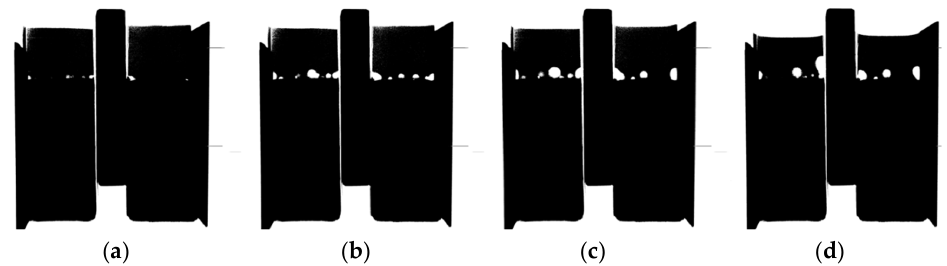
Figure 19. Void development when water is absorbed by the mortar substrate: ( a ) Reference image; ( b ) After 7 min; ( c ) After 17 min; ( d ) After 240 min. ( b ) After 7 min; ( c ) After 17 min; ( d ) After 240